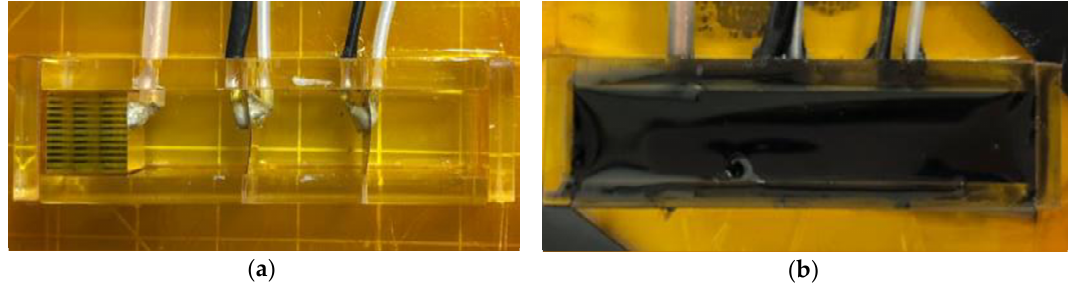
Figure 3. Fabrication of the proposed absorber: ( a ) the acrylic mold and ( b ) the liquid acoustic window.